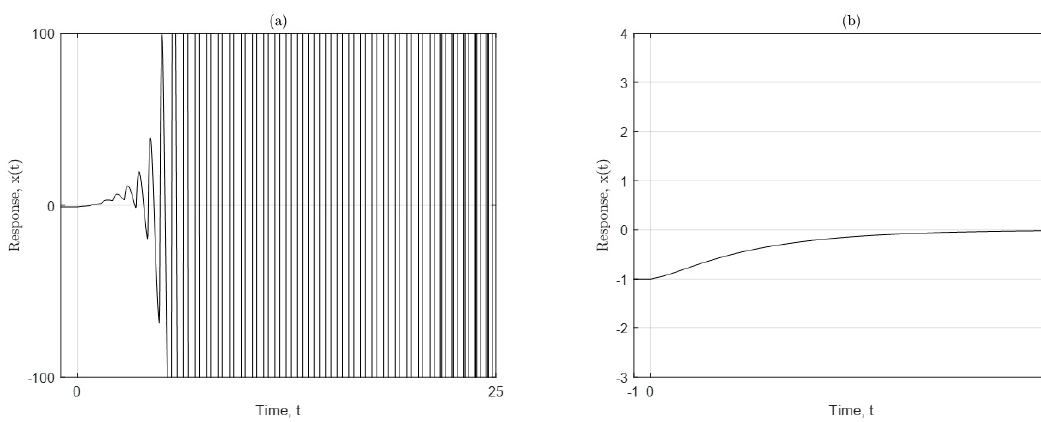
Figure 2. Rightmost spectrum of the characteristic equation. The spectrum values are denoted as black dots. The blue and red lines are the isolines of the real and imaginary parts of the characteristic equation to zero, respectively. ( a ) Without state feedback. A few eigenvalues are located in the right- half plane of the imaginary axis. ( b ) With a state feedback controller. All eigenvalues are located in the open left-half plane of the imaginary axis.